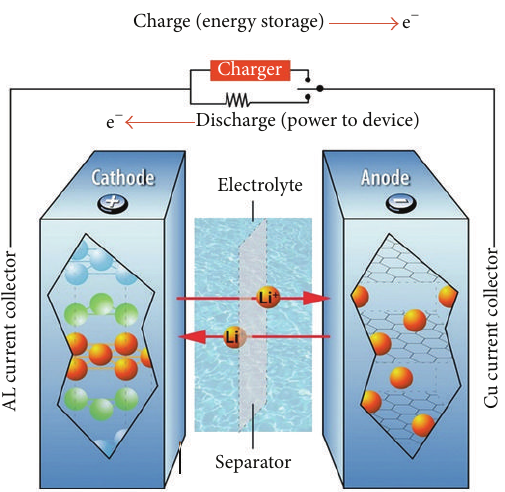
Figure 3: Lithium-ion battery charge/discharge diagram.